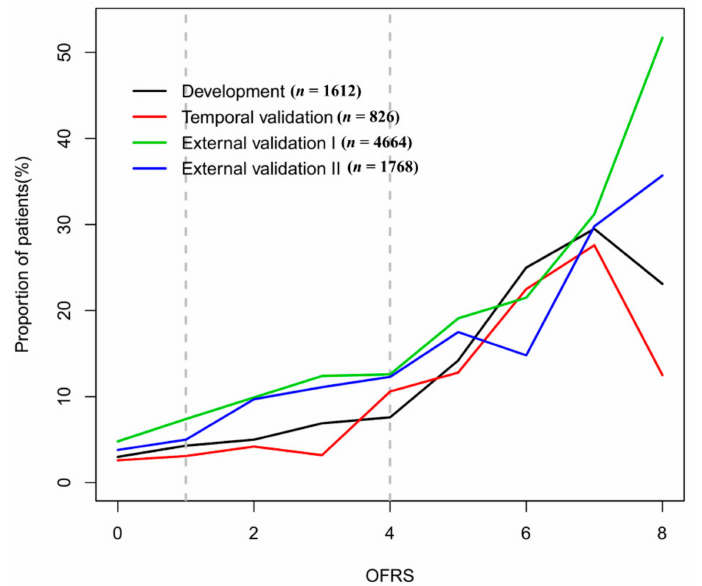
Figure 4. Association between OFRS and 90-day mortality by plotting the 90-day mortality rate according to the risk scores in each cohort. OFRS, operation frailty risk